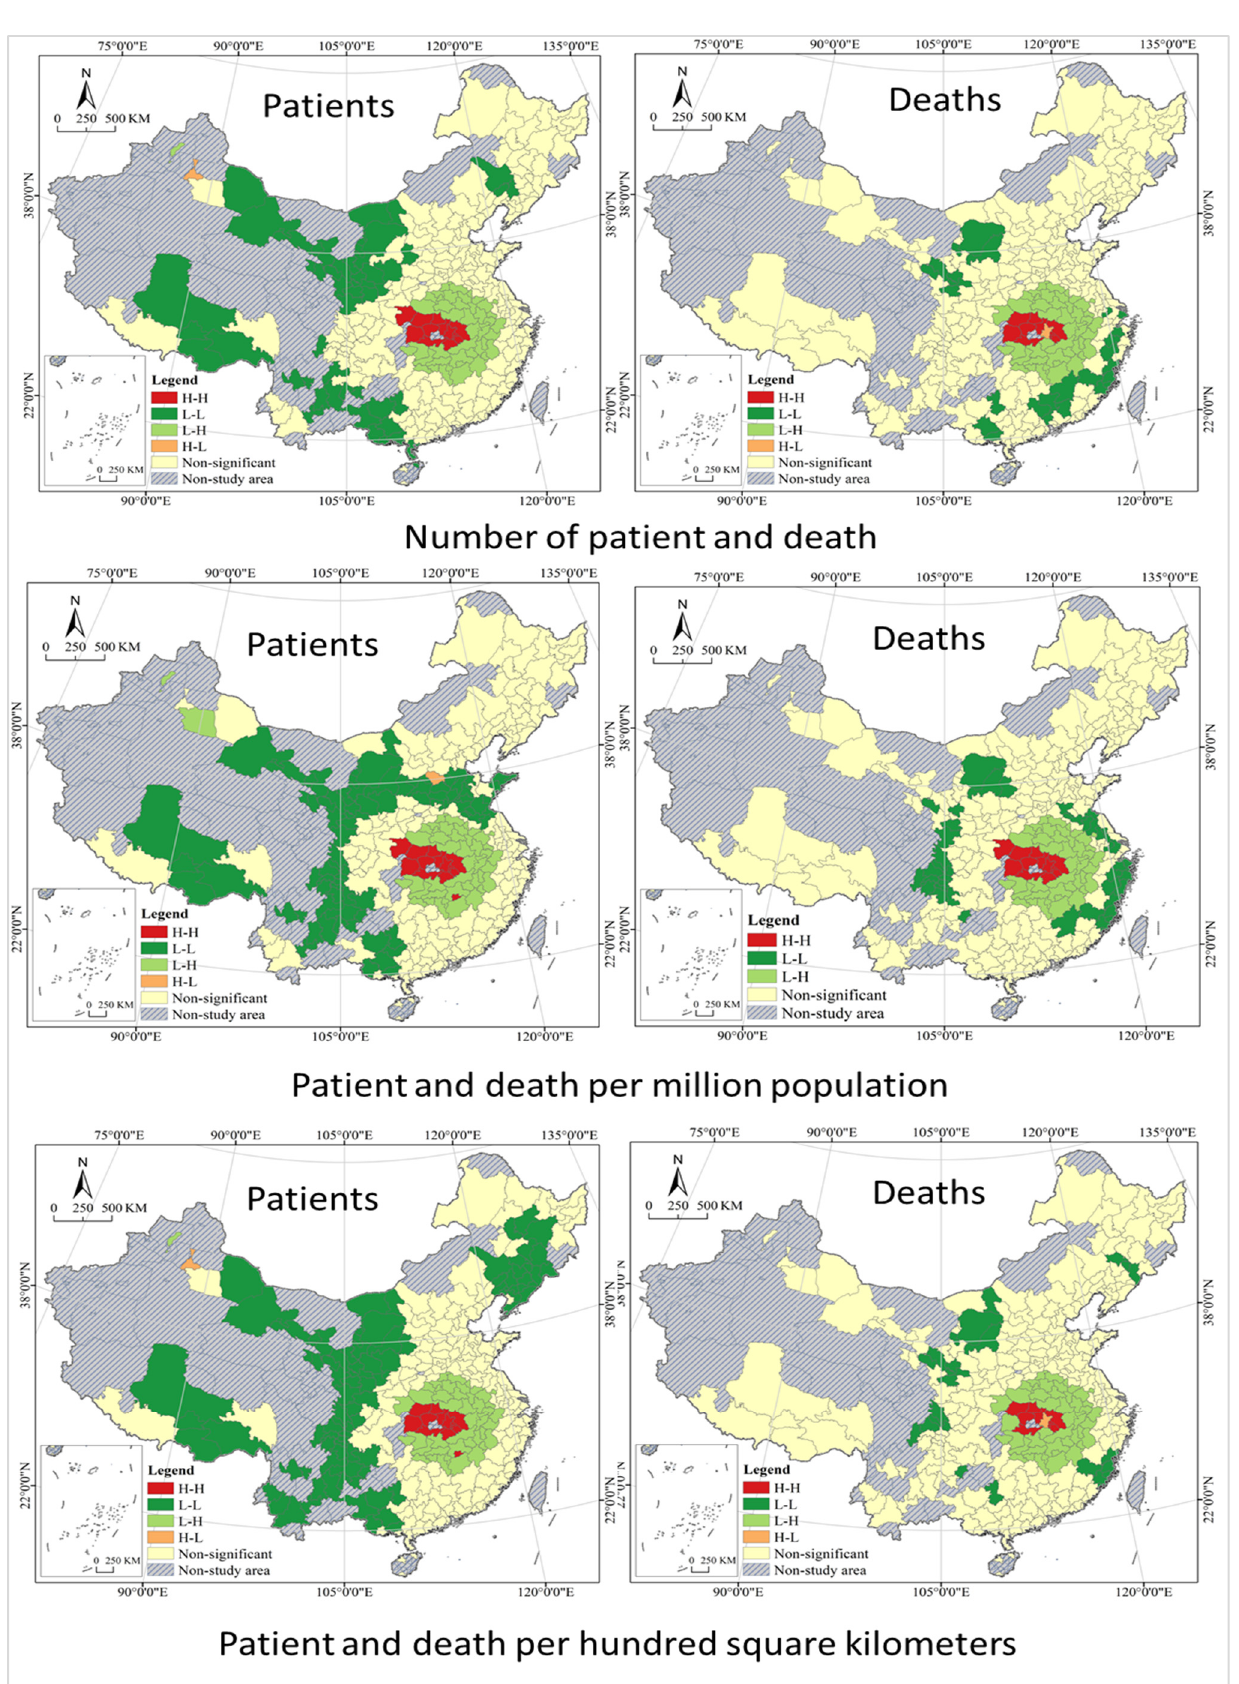
Figure 5. Spatial autocorrelation analysis of COVID-19 in China cities.